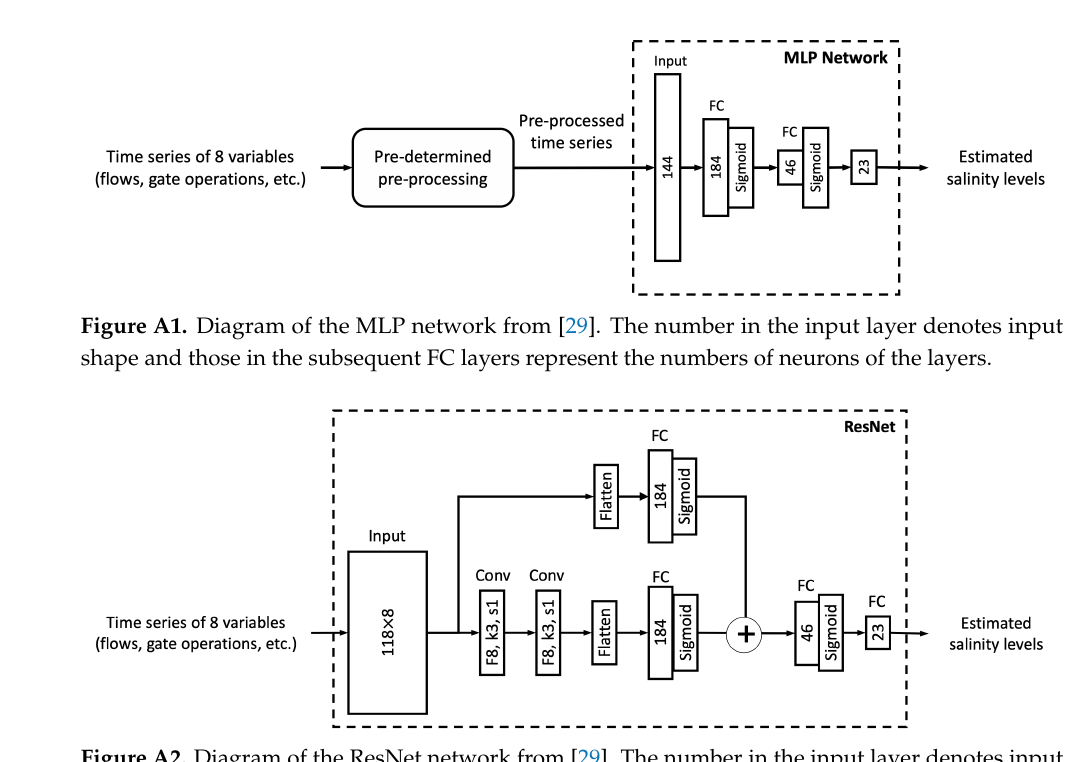
Figure A2. Diagram of the ResNet network from [29]. The number in the input layer denotes input shape and those in the FC layers represent the numbers of units/neurons of the layers. In the convolutional layers following the input layer, “f” denotes the number of convolutional filters, “k” denotes size of convolutional kernels and “s” denotes